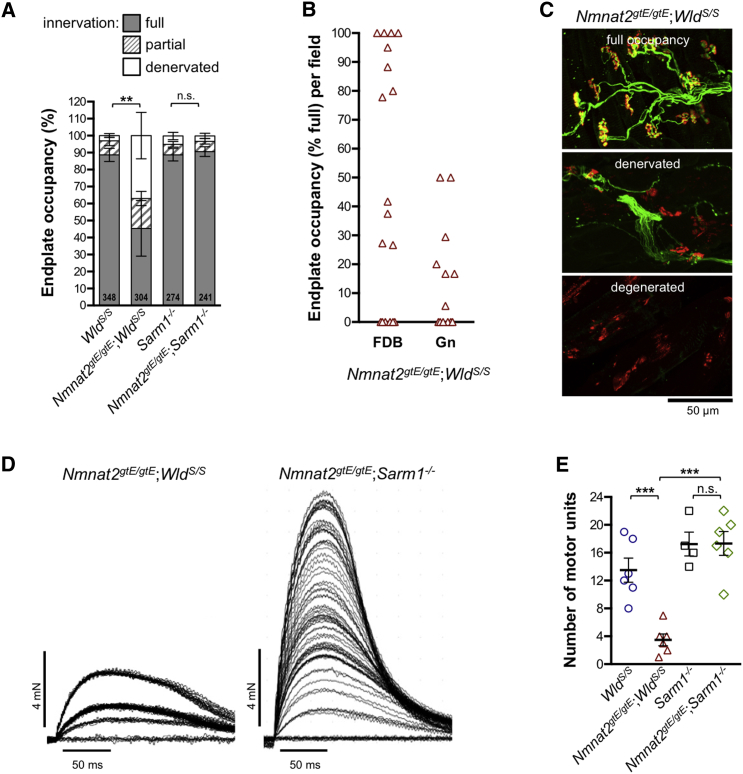
Localized Loss of NMJ Innervation from Distinct Motor Unit Groups in FDB Muscle of Nmnat2gtE/gtE;WldS/S Mice(A) Percentage of fully occupied (full), partially occupied (partial), and denervated endplates in FDB muscles of 10-month-old mice of the indicated genotypes (method as in Figure 2A). Total numbers of NMJs analyzed in muscles from 5–9 mice per genotype (male and female) are listed at the base of each column. Means ± SEM of occupancy per animal are plotted (NS, not significant [p > 0.05] or ∗∗p < 0.01 in one-way ANOVA with Tukey’s multiple comparisons of full innervation, selected comparisons).(B) Percentage of full occupancy of endplates per imaged field revealed a zonal pattern of denervation in Nmnat2gtE/gtE;WldS/S FDB at 10 months, with more widespread denervation in gastrocnemius (Gn). Fields with normal levels of full occupancy (80%–100%) were relatively common in FDB (7/18) but absent in gastrocnemius (average of 16.9 and 11.6 endplates per field, respectively).(C) Representative confocal z series projections of fixed FDB muscle preparations showing merged α-bungarotoxin (red) and βIII-tubulin (green) signals, highlighting regional variability in Nmnat2gtE/gtE;WldS/S endplate occupancy at 10 months. In addition to regions with widespread full occupancy (top panel) or denervation (middle panel), there were areas containing degenerated endplates (bottom panel, not included in quantifications).(D) Isometric twitch tension recordings for representative Nmnat2gtE/gtE;WldS/S and Nmnat2gtE/gtE;Sarm1−/− FDB muscle-tibial nerve preparations showing progressive, discrete recruitment of motor units (incremental steps in twitch tension) during continuously graded stimulation of the nerve.(E) Motor unit numbers in FDB muscles from 10-month-old male mice of the indicated genotypes (n = 4 or 6 muscles from 2 or 3 mice as shown). Individual values and means ± SEM are plotted (NS, not significant [p > 0.99] or ∗∗∗p < 0.001 in one-way ANOVA with Tukey’s multiple comparisons, selected comparisons).See also Figure S2.